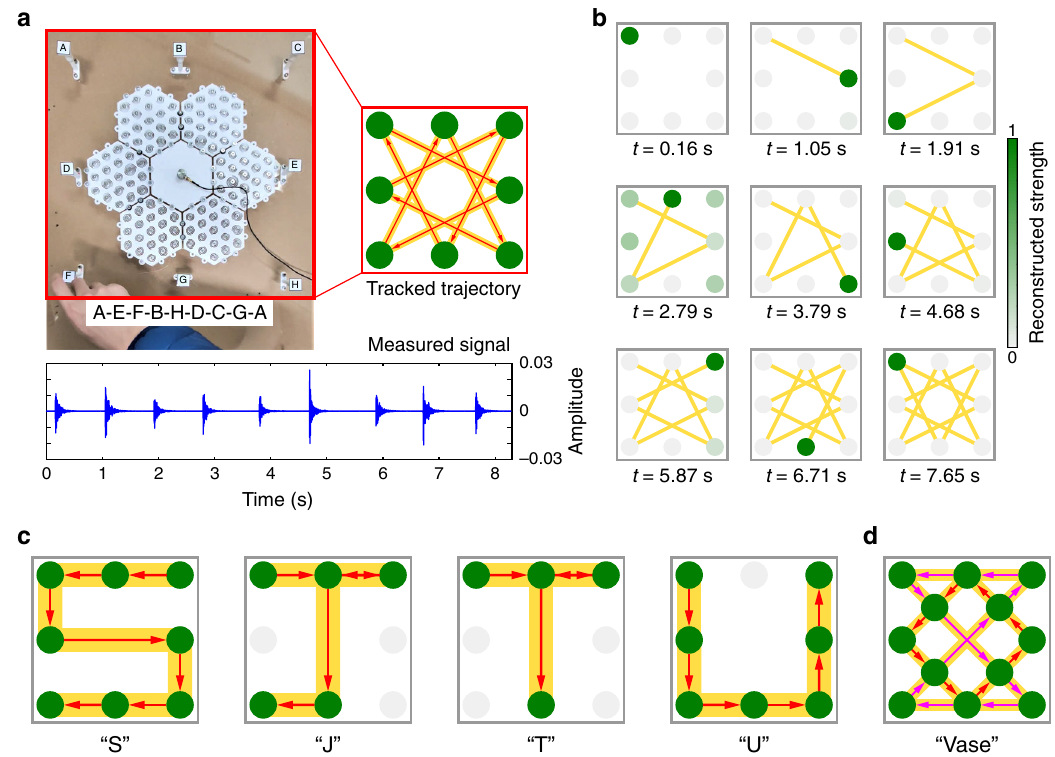
Fig. 5 Trajectory tracking of vibration events. a Experimental setup for trajectory tracking with eight probes. The probes are tapped along the trajectory “ A-E-F-B-H-D-C-G-A ” , and the vibration signals are measured by the single sensor. The trajectory is successfully tracked according to the identi fi cation of vibration events. b Reconstruction results of vibration events. The dynamic process can be found in Supplementary Movie 1. c The tracked trajectories of “ SJTU ” . d The tracked trajectory “ Vase ” with 12 probes. The dynamic process can be found in Supplementary Movie